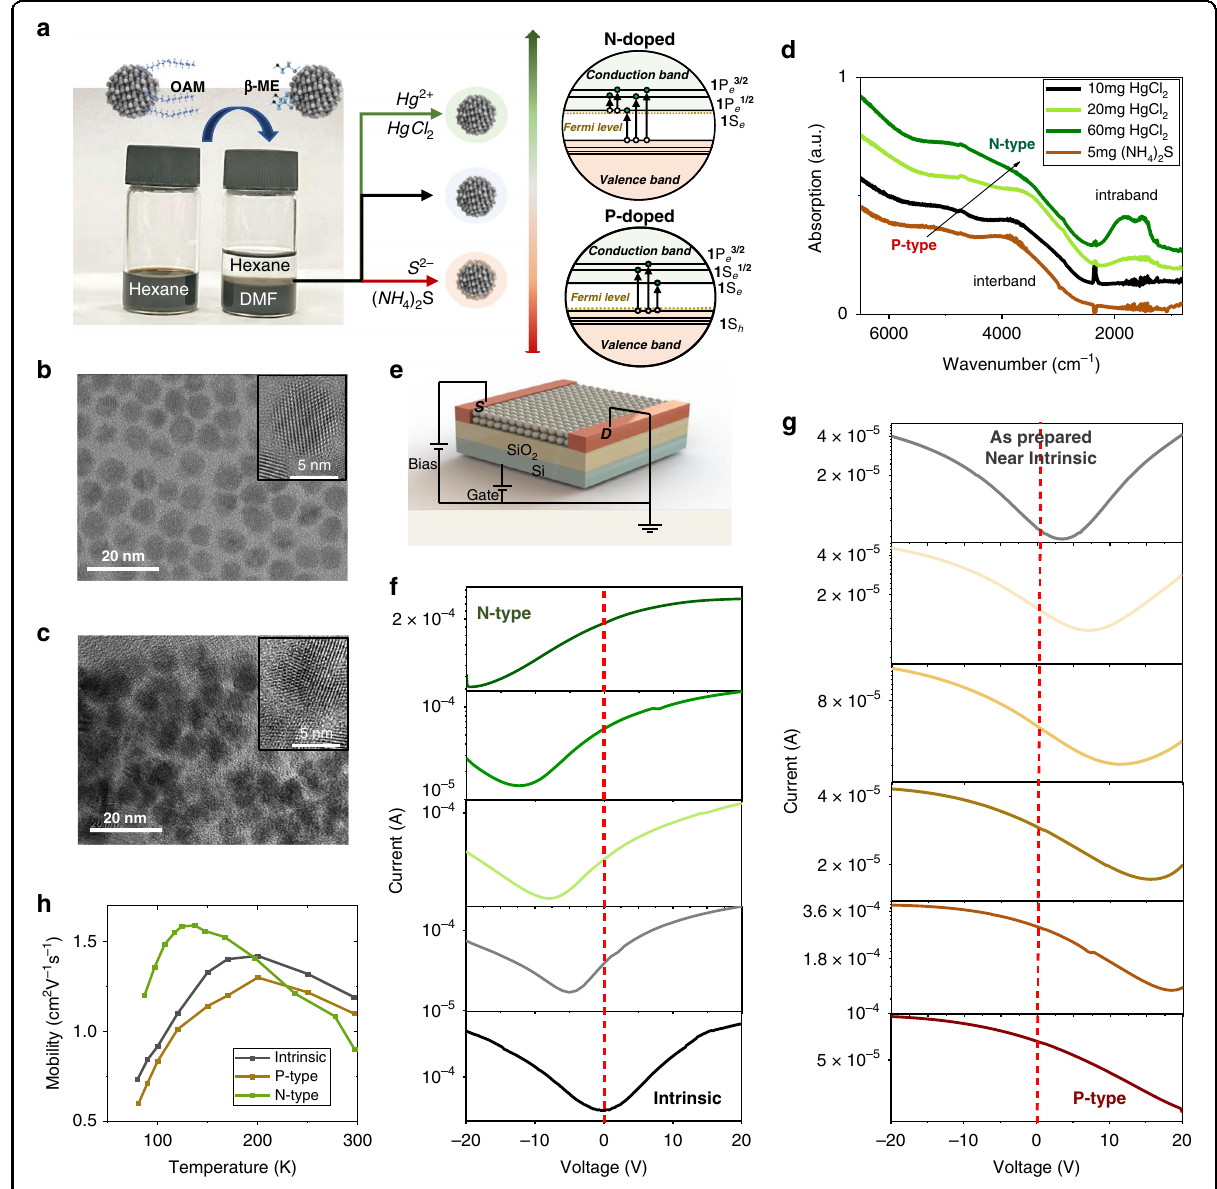
Fig. 1 HgTe CQD. a Phase transfer and Doping control. b TEM of OAM capped HgTe CQD. c TEM of HgTe CQD after phase transfer. d Absorption spectra of CQD with different doping. e Schematic diagram of FET device. f , g FET transfer curves of p-type, n-type and intrinsic on CQD solids at room temperature. h Mobility as a function of